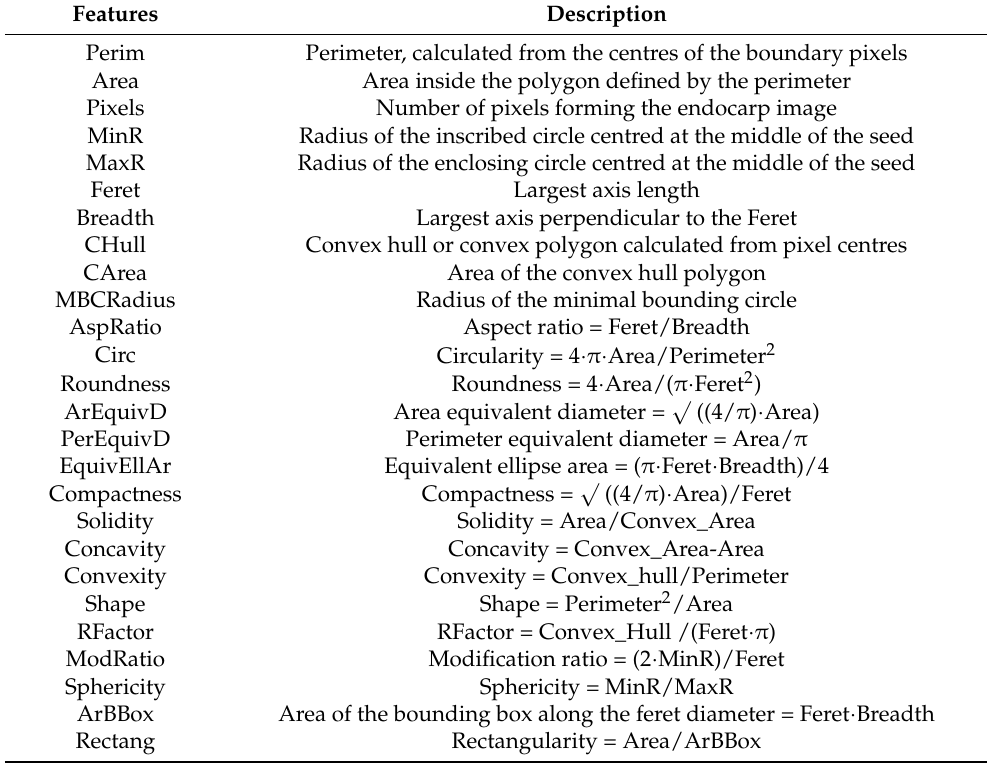
Table 6. List of morphometric features measured on each